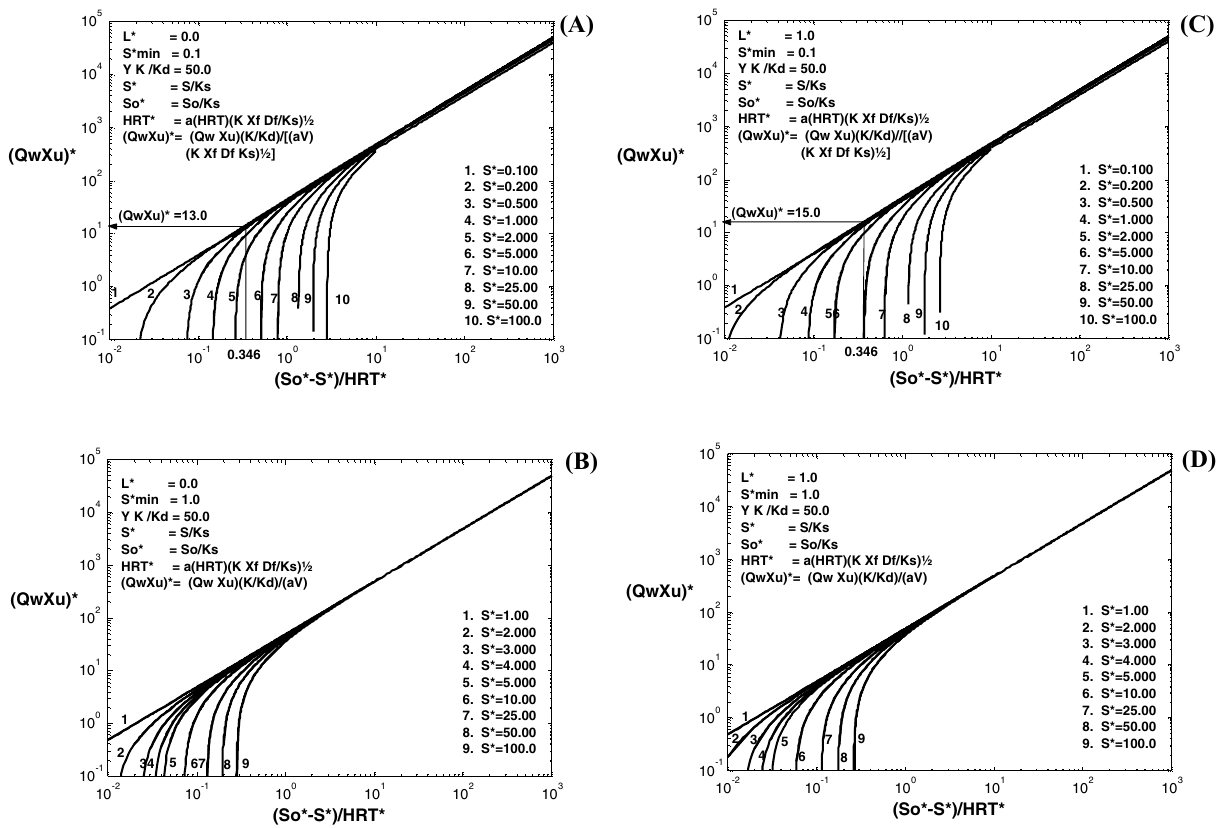
L * = 0.0, S ∗ min = 0.10, b L * = 0.0, S ∗ min = 1.0, c L * = 1.0, S ∗ min = 0.10 and d d = 50.0, a